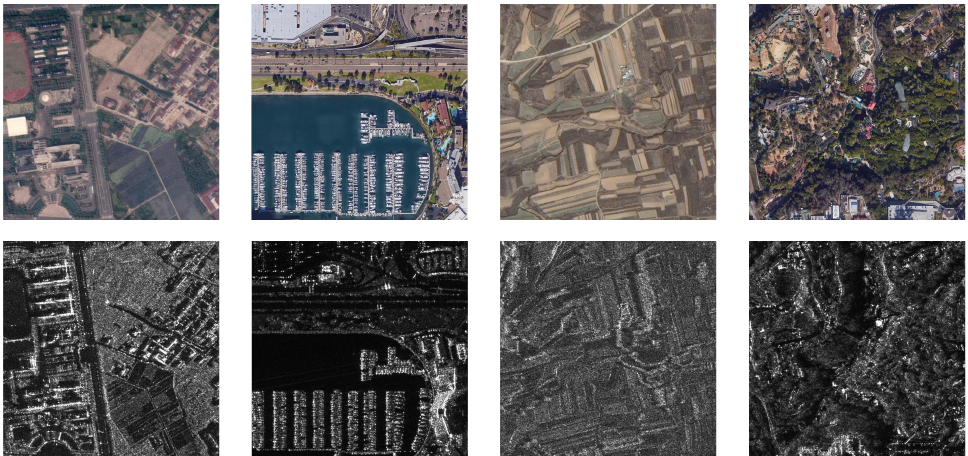
Figure 1. Comparison between SAR ( bottom ) and optical ( top ) imagery of the same